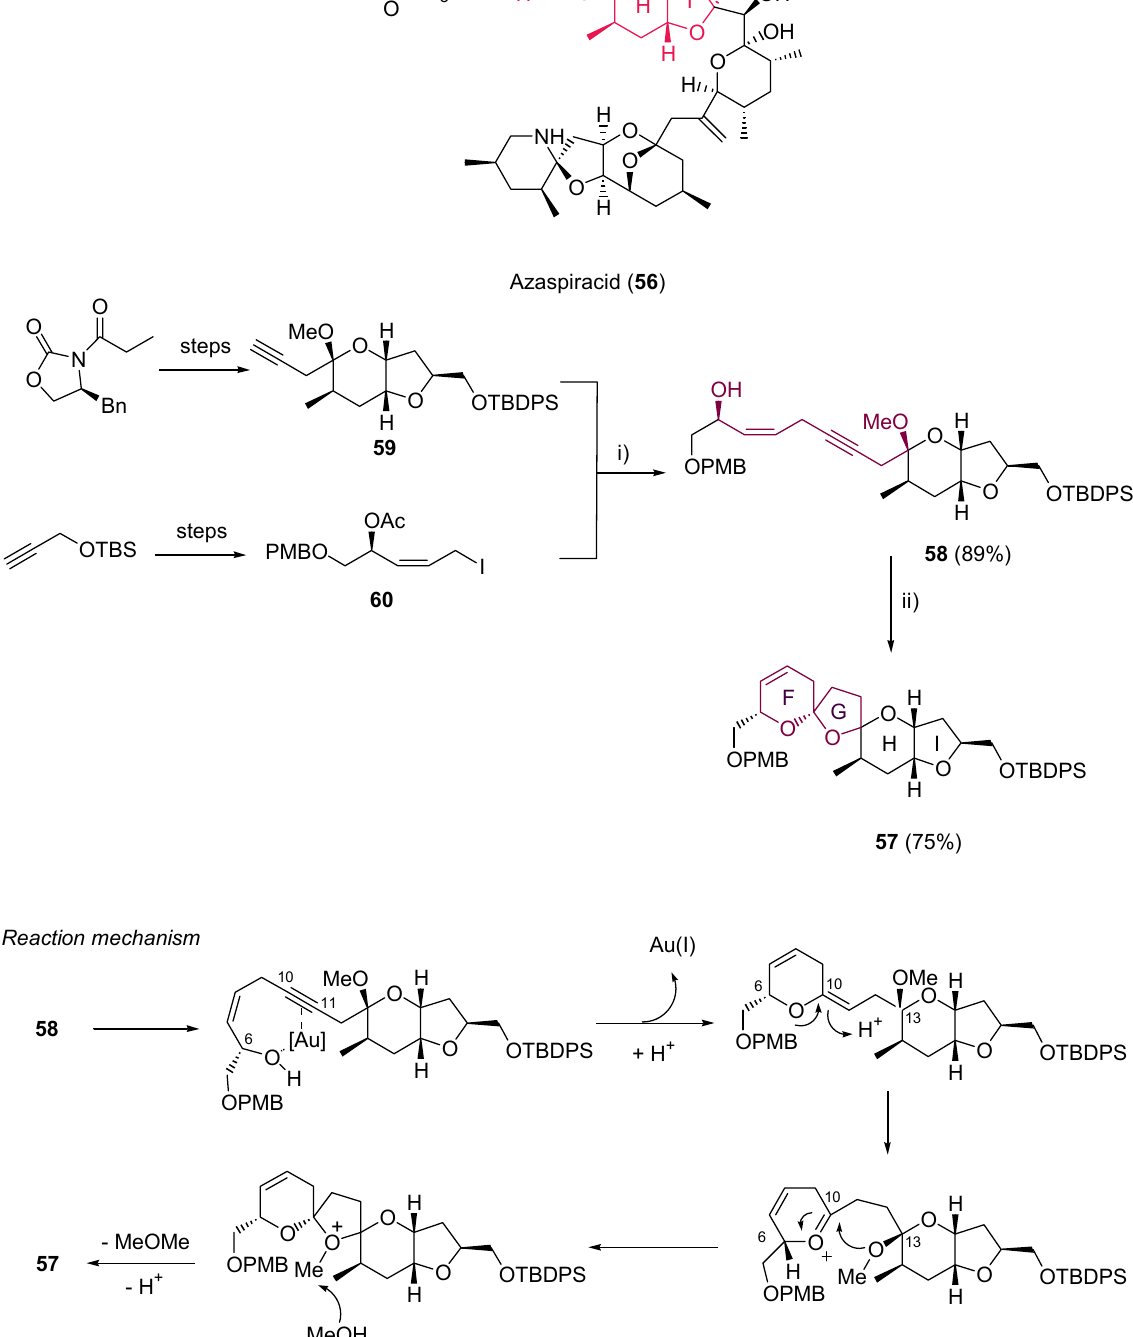
Scheme 18. Synthesis of rings F and G in azaspiracid and reaction